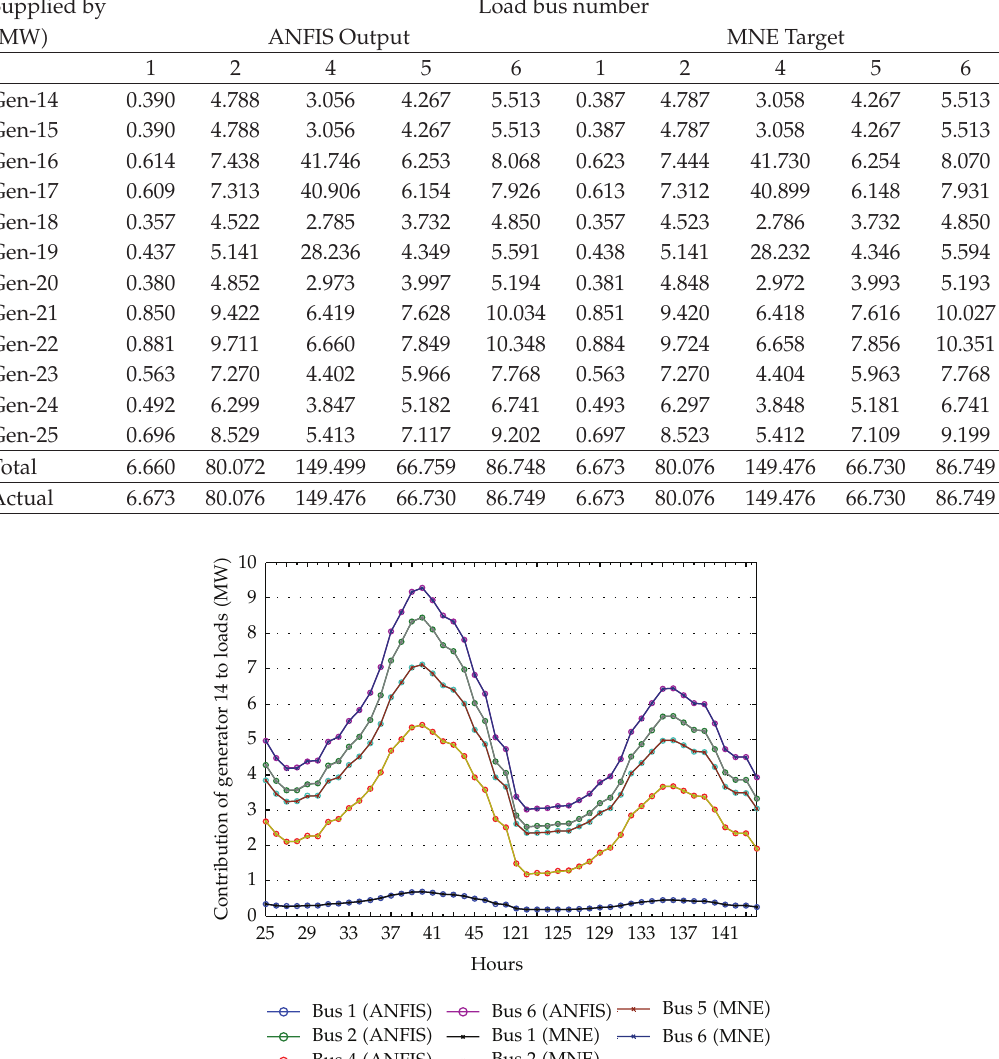
Table 2: Analysis of real power allocation for the 25-bus equivalent system during hour 33.